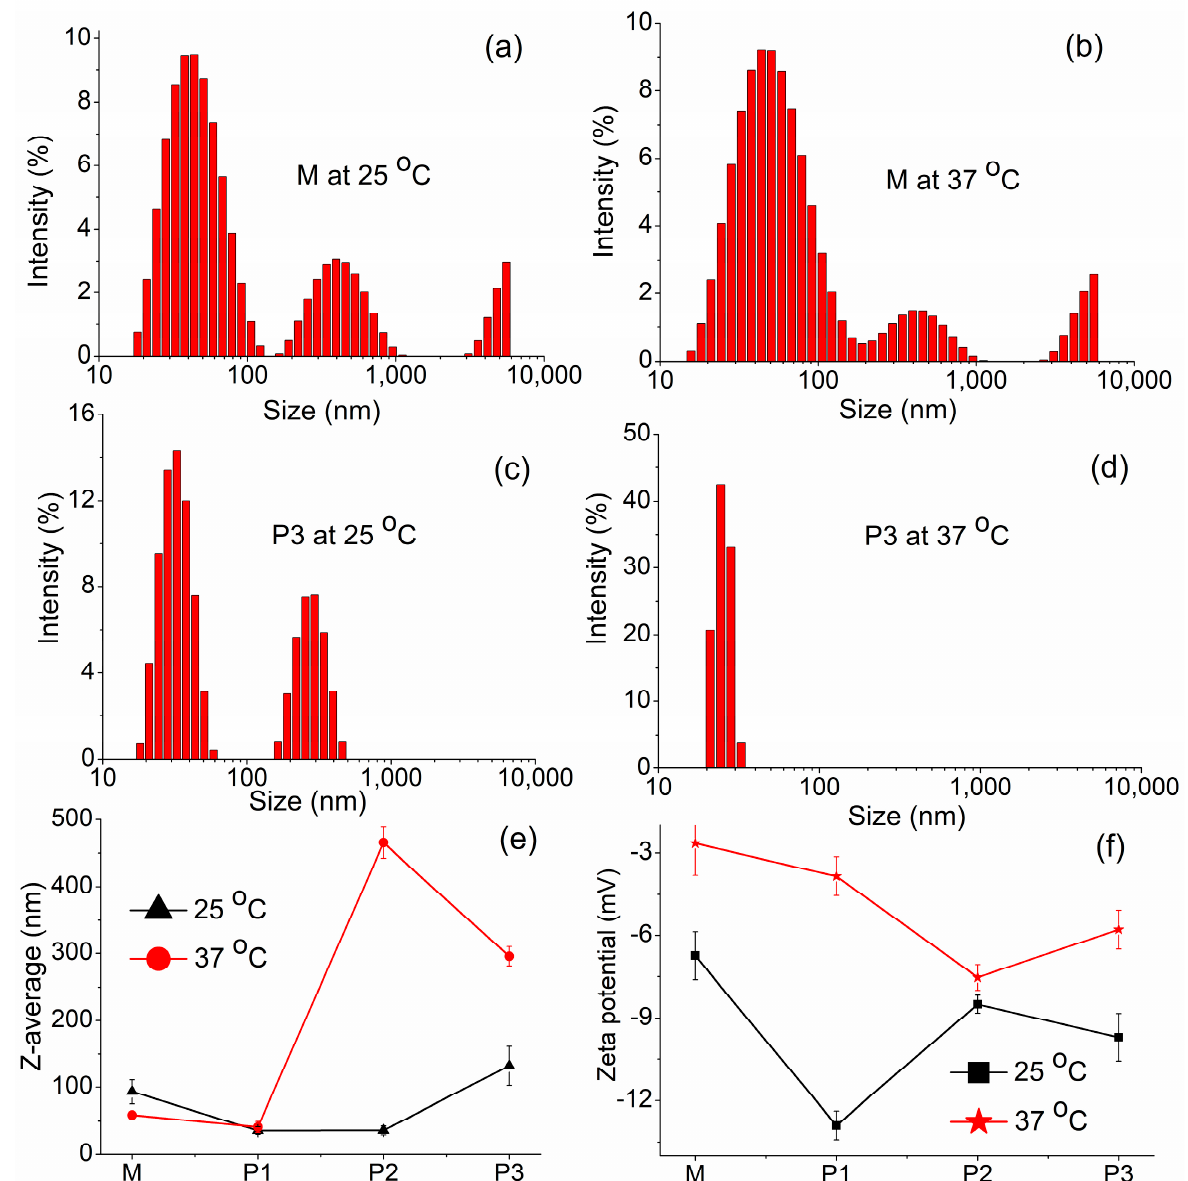
Figure 3. Dynamic light scattering data of polyurethane/peptide-based carriers: ( a – d ) Size distribution of micelles for M and P3 samples at 25 and 37 °C, respectively; The influence of the polyurethane/peptide mass ratio on the ( e ) Z-average and ( f ) zeta potential at 25 and 37 °C.